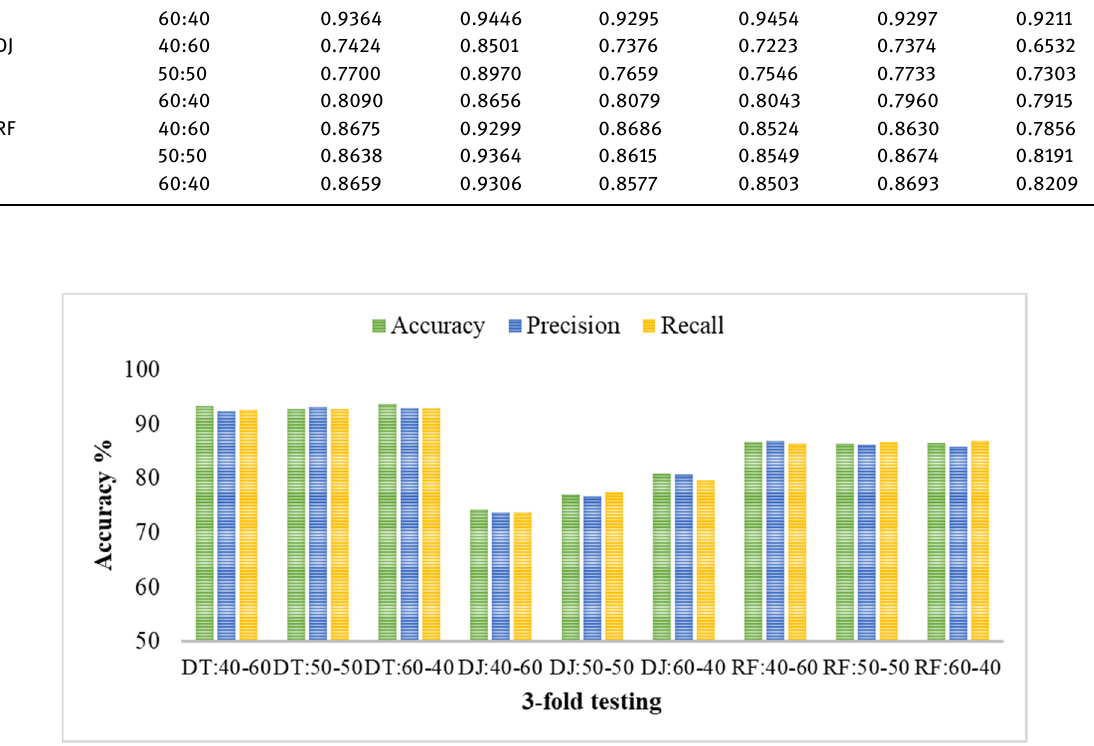
Figure 4: The visualization of the IoT - FSP model results.